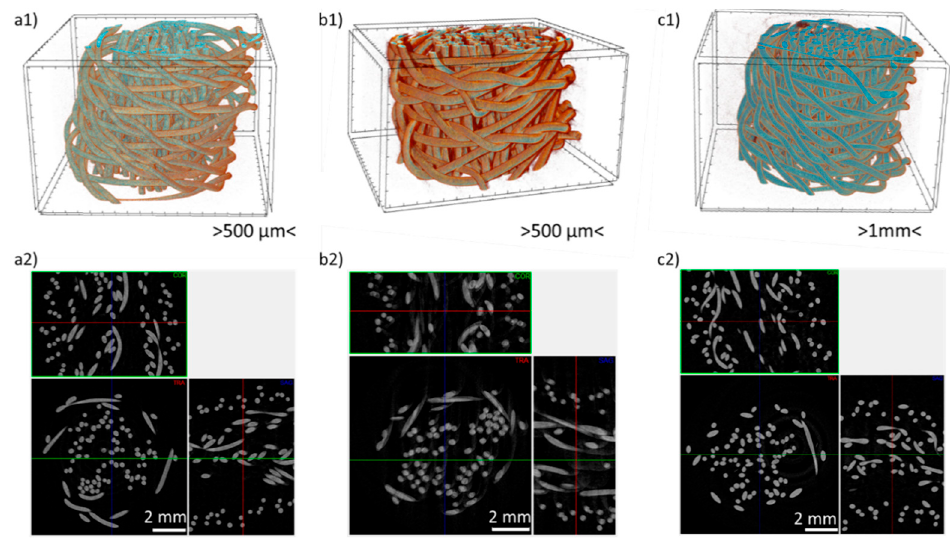
Figure 7. Representative 3D micro-CT reconstruction and micro-CT cross-sections images of the braided scaffolds containing ( a1 , a2 ) PLA, ( b1 , b2 ) PLA+0.5[(f-EG)+Ag], and ( c1 , c2 ) PLA+1[(f-EG)+Ag].